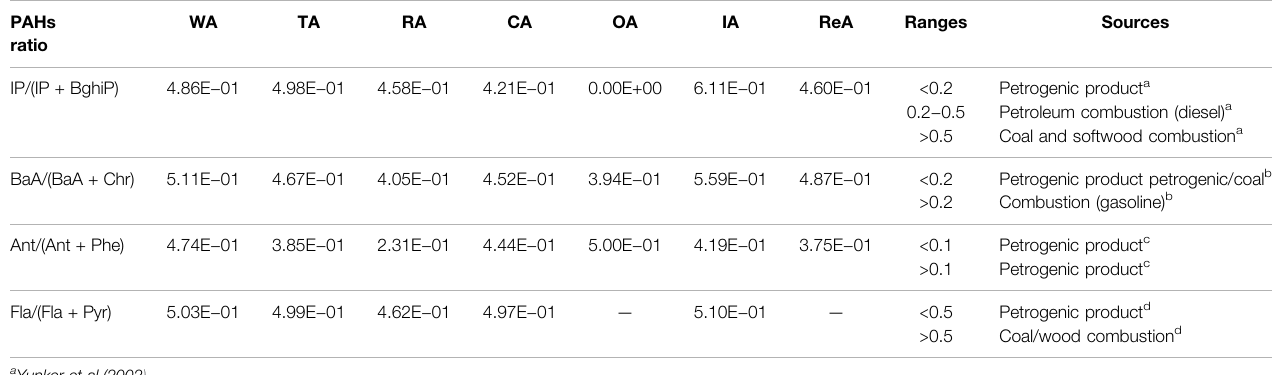
TABLE 1 | Calculated diagnostic ratio, ranges, and possible sources.